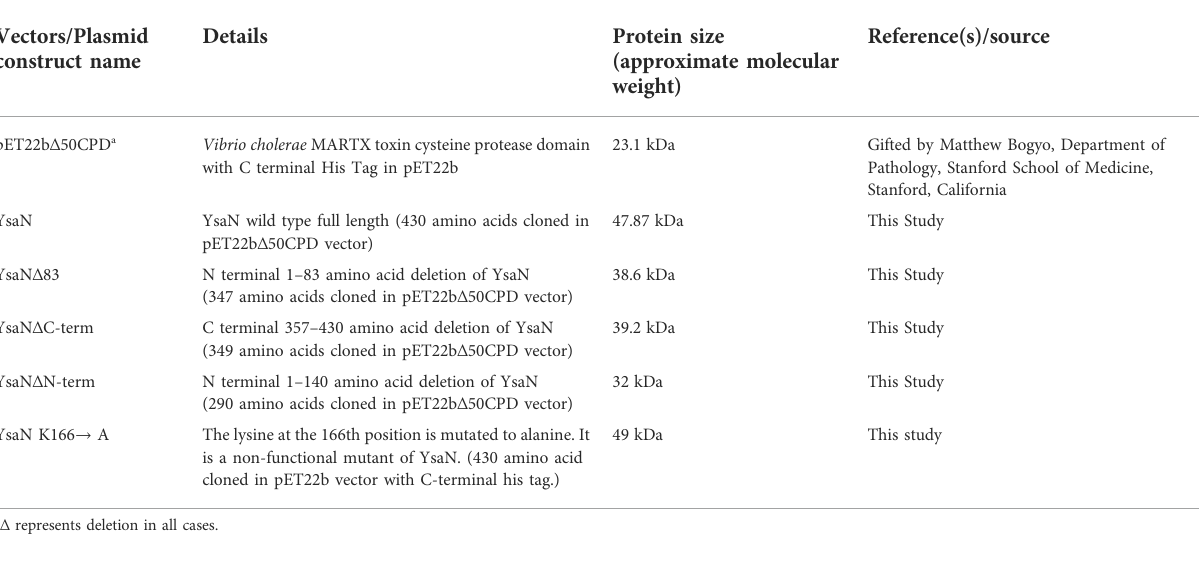
TABLE 1 List of clones/vectors used in this study.